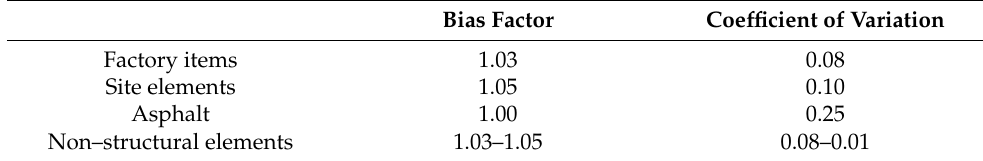
Table 3. Bias factor and variation coefficient for structural and nonstructural elements.